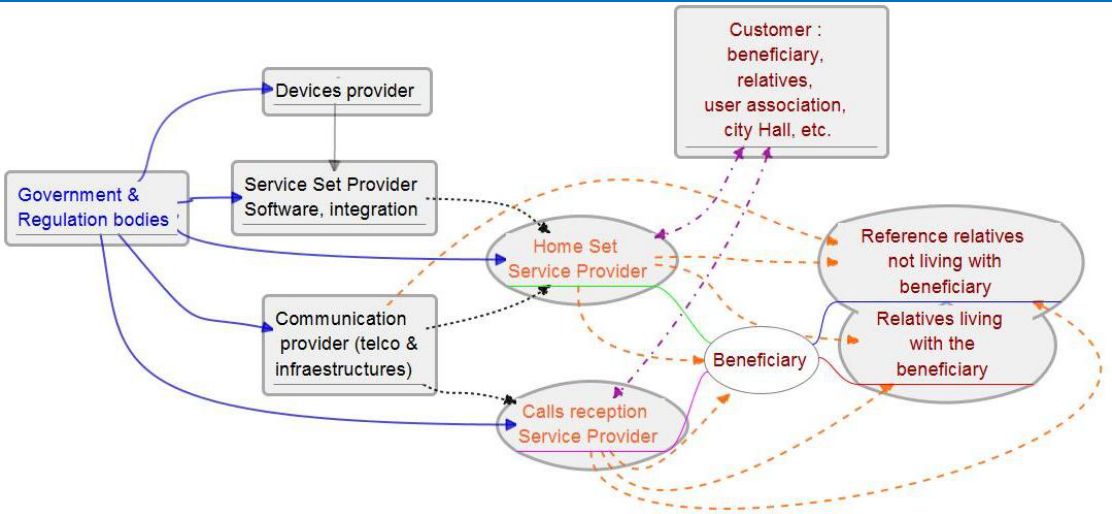
Figure 8. Service provision chain of services that include calls to service centers: In blue font (outgoing full blue lines) quaternary stakeholders; black (dotted) tertiary, orange (dashed) secondary and red font primary. Violet lines (dash-dot) show contractual and financial